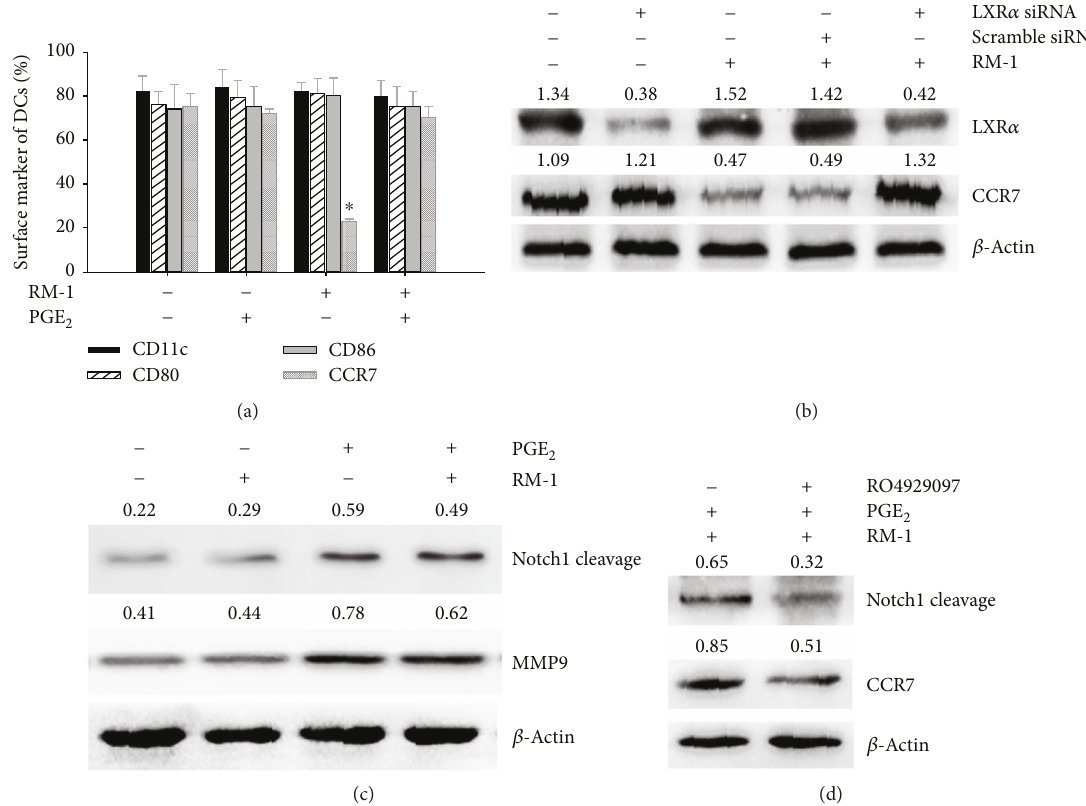
Figure 2: PGE upregulates CCR7 expression via regulation of LXR α and Notch1. (a) Surface markers of CD80, CD86, and CCR7 in 2 maturing DCs cultured in RM-1-conditioned medium were analyzed by fl ow cytometry. Data were presented as the mean ± SD of 3 independent experiments, each performed in triplicate ( ∗ P < 0 05 ). (b) LXR α silencing partially reversed the inhibition of CCR7 expression induced by RM-1-conditioned medium in DCs. (c) Increase in expression of MMP9 and Notch1 cleavage by PGE analyzed by Western blot. (d) Notch1 cleavage inhibitor RO4929097 partially reversed the inhibition of CCR7 expression induced by RM- 1-conditioned medium in DCs using Western